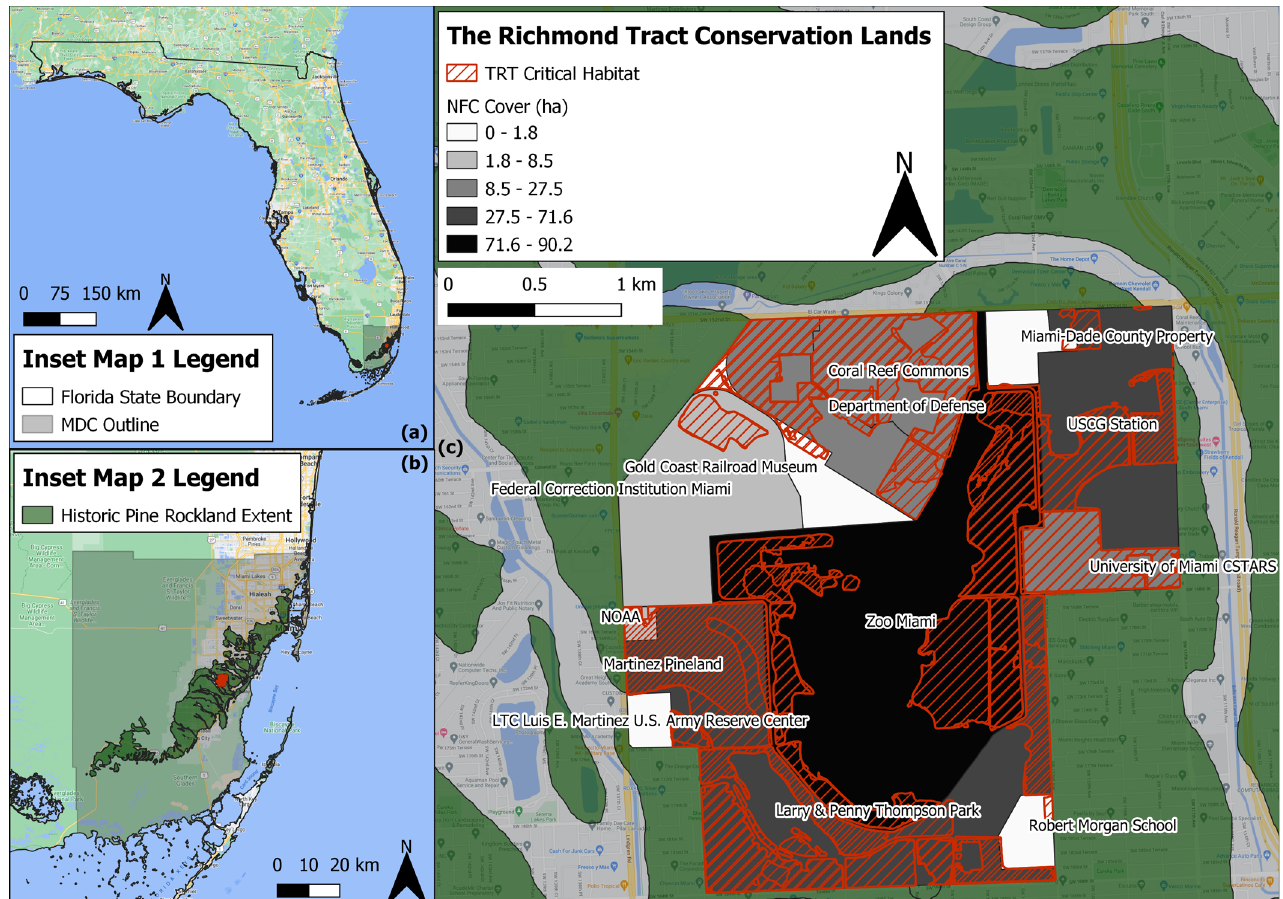
Figure 1. The Richmond Tract is found in Miami–Dade County, Florida, USA, within the historic extent of the pine rockland ecosystem. ( a ) The pine rockland ecosystem is found exclusively in southeastern peninsular Florida spanning from North Miami into Everglades National Park, with some remnants in the Florida Keys. ( b ) The dark green area is the historic extent of pine rocklands and the red portion is the Richmond Tract. ( c ) Richmond contains swaths of critical habitat (red hashed lines) and properties have varying amounts of Natural Forest Community (NFC) land, with Zoo Miami containing the most. This map was created on QGIS version 3.18.2 with layers from Google (base map), MDC (county outline and property ownership), USFWS (critical habitat), and J. Possley (historic pine rockland extent).